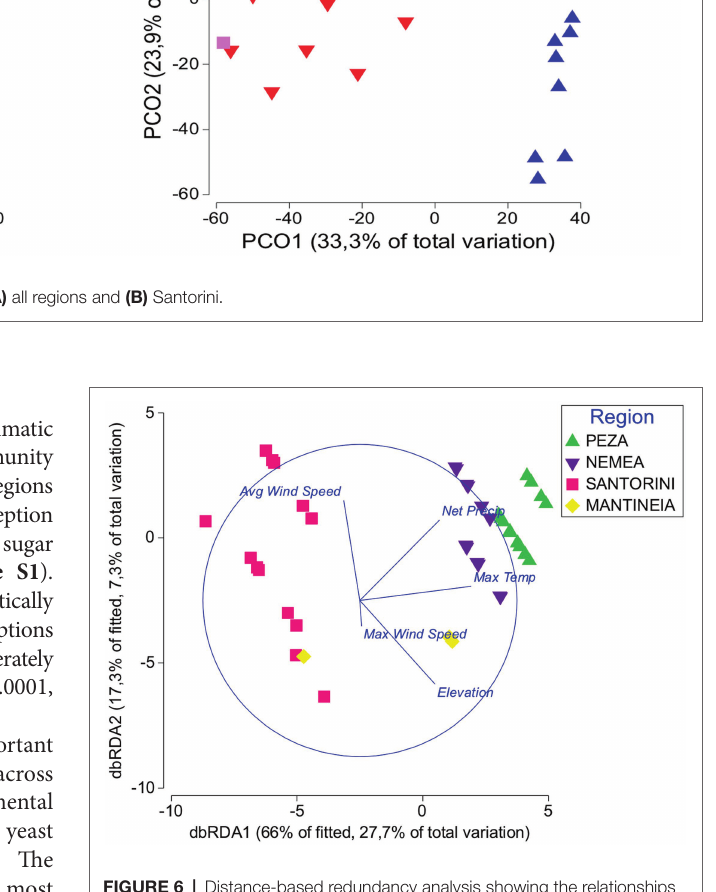
FIGURE 6 | Distance-based redundancy analysis showing the relationships between yeast communities in different regions (Peza, Nemea, Santorini, and Mantineia) and most important environmental factors (Average Wind Speed, Net Precipitation, Elevation, Maximum Temperature, and Max Wind